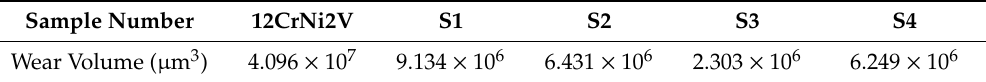
Table 6. Wear volume of the laser melting deposited Fe-based alloy gradient